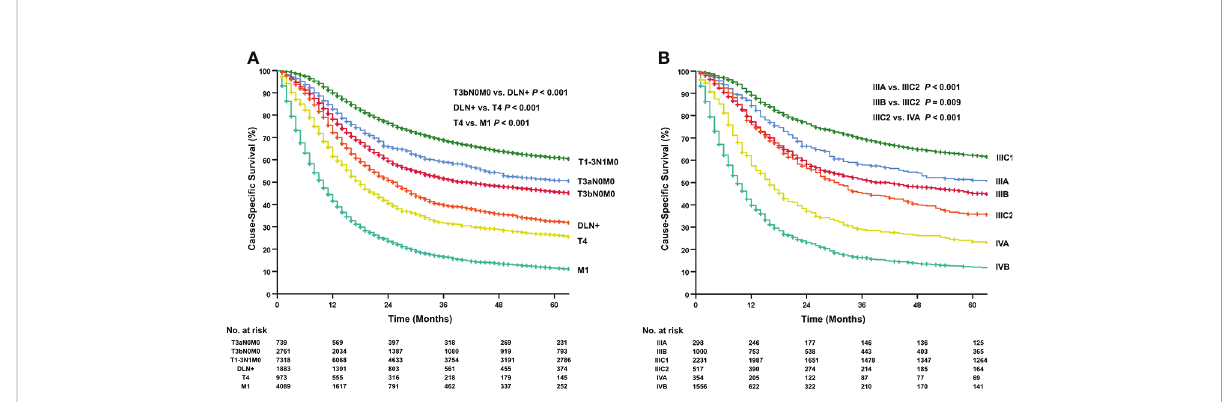
FIGURE 2 Kaplan-Meier curves for cause-speci fi c survival. (A) stage III-IV cervical cancer (1988 – 2016). (B) stage III-IV cervical cancer (1988 – 2003). Trend analyses for all groups in two cohorts were signi fi cant. All P values had been adjusted by the Benjamini-Hochberg procedure and adjusted P <0.05 was considered statistically signi fi cant.